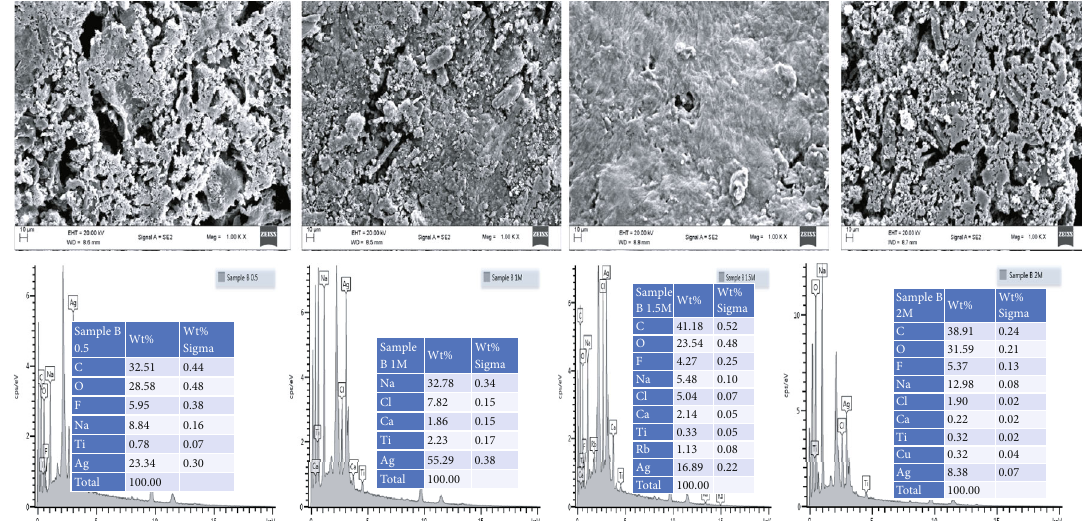
Figure 5: SEM images and EDX spectra of HAART-AgNPs (0.5 M) (A1 and A2), HAART-AgNPs (1 M) (B1 and B2), HAART-AgNPs (1.5 M) (C1 and C2), and HAART-AgNPs (2 M) (D1 and D2),